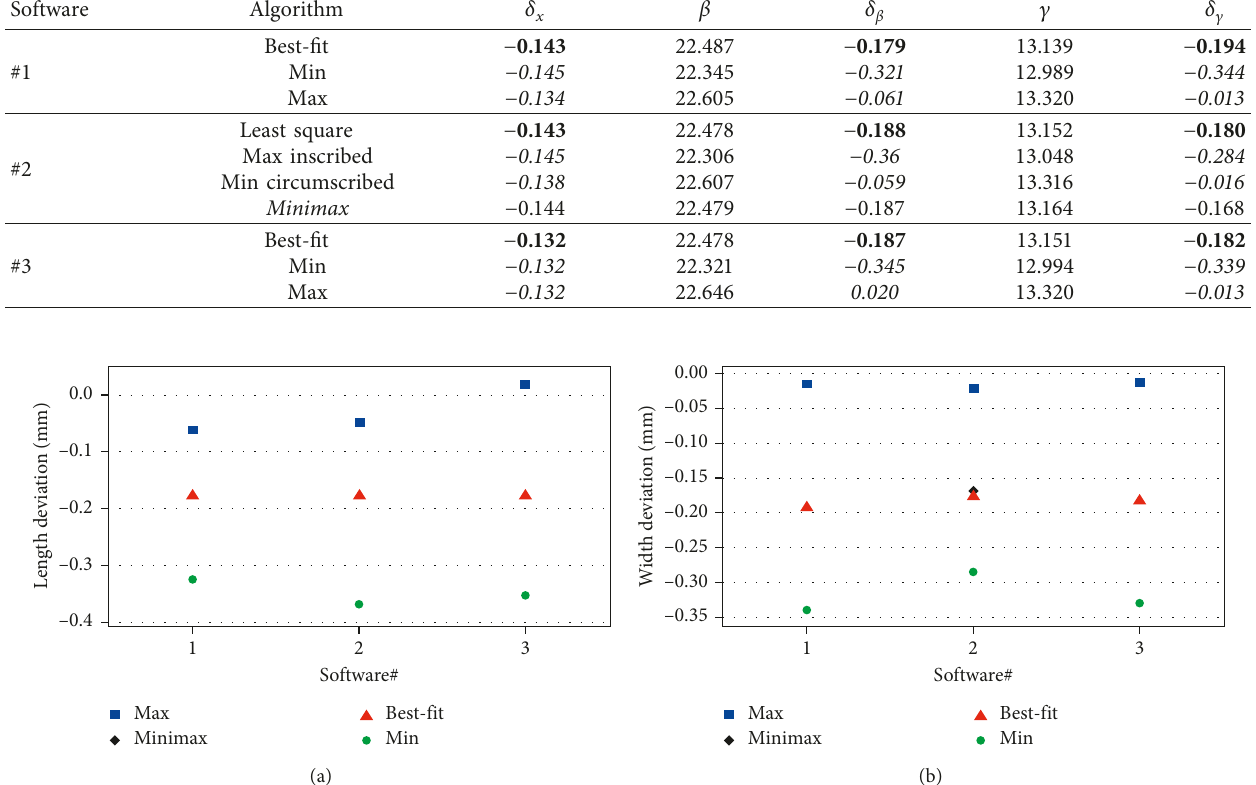
Table 4: Results for the inspection of the oblong hole (width � 13.333mm and length � 22.666mm).